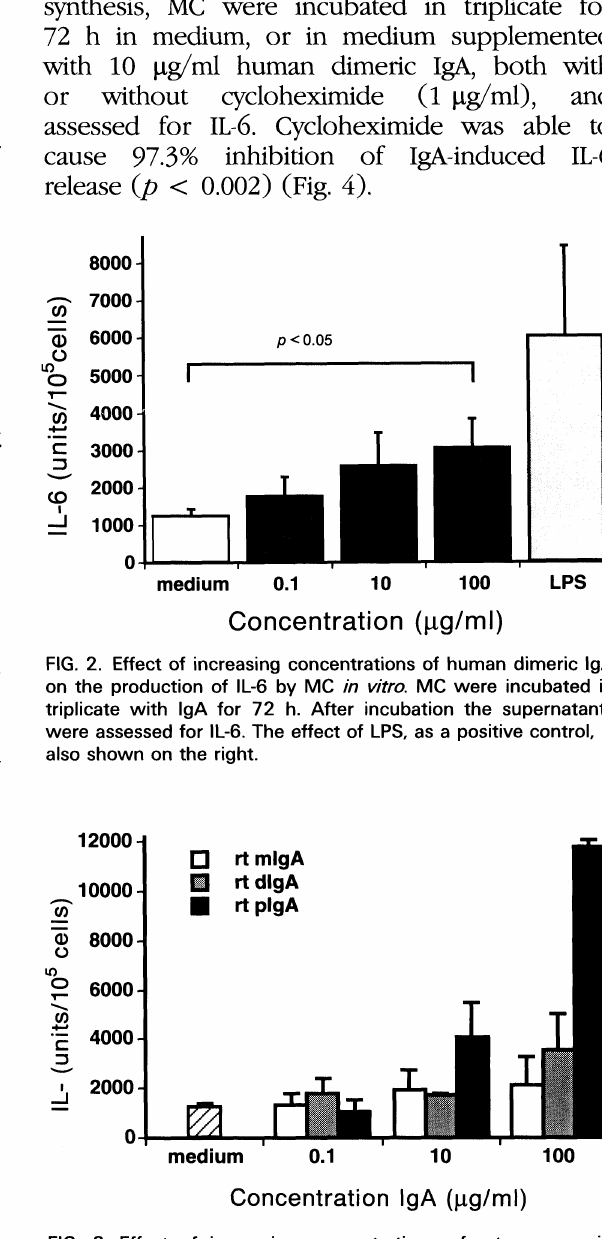
FIG. 1. Binding of 1251-1gA to MC following incubation of MC with increasing concentrations of 1251-labelled human dimeric IgA for 16 h at 4C. One of four representative experiments is shown. Results are expressed as the mean -t- S.E.M. of triplicate wells.